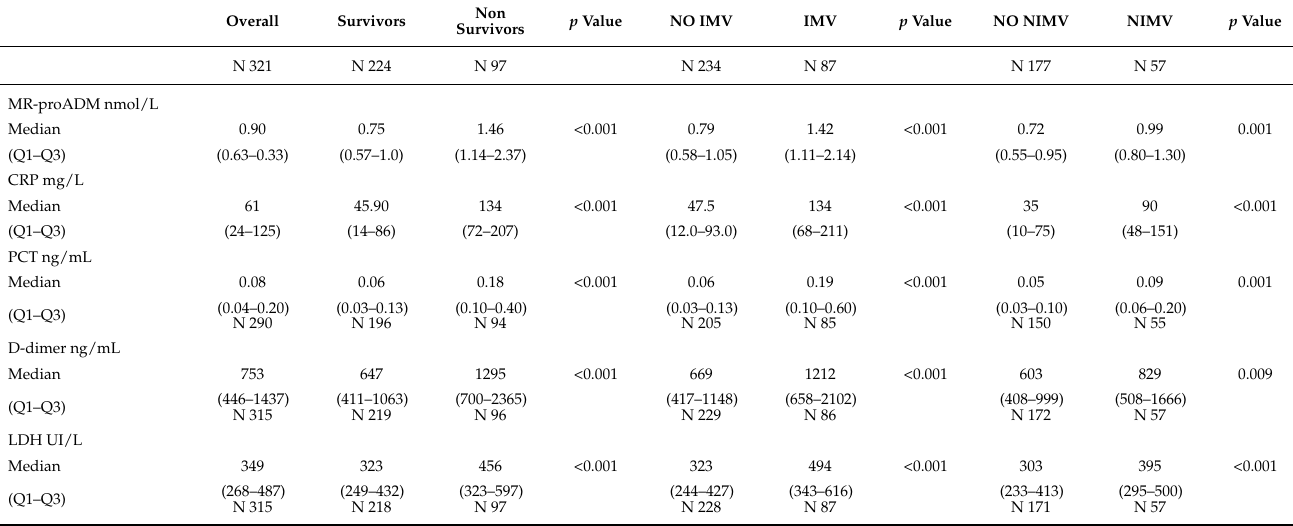
Table 2. Biomarkers values at triage admission.